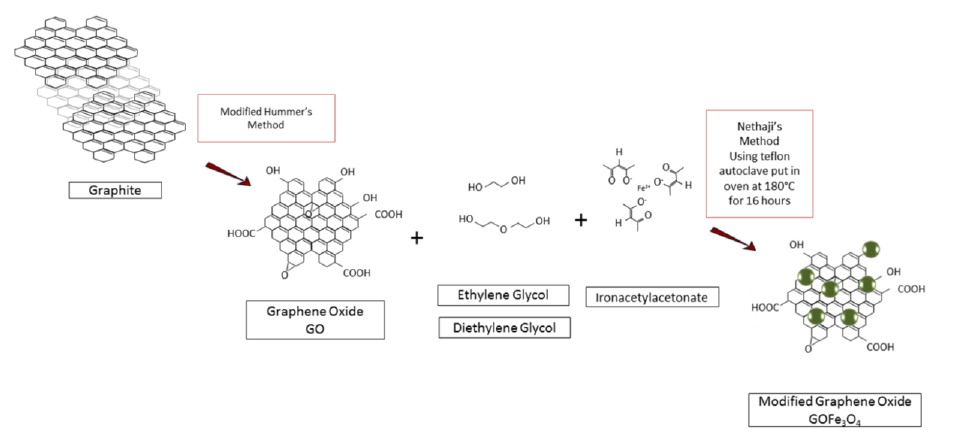
Figure 1. Schematic illustration of preparation of GO@Fe 3 O 4